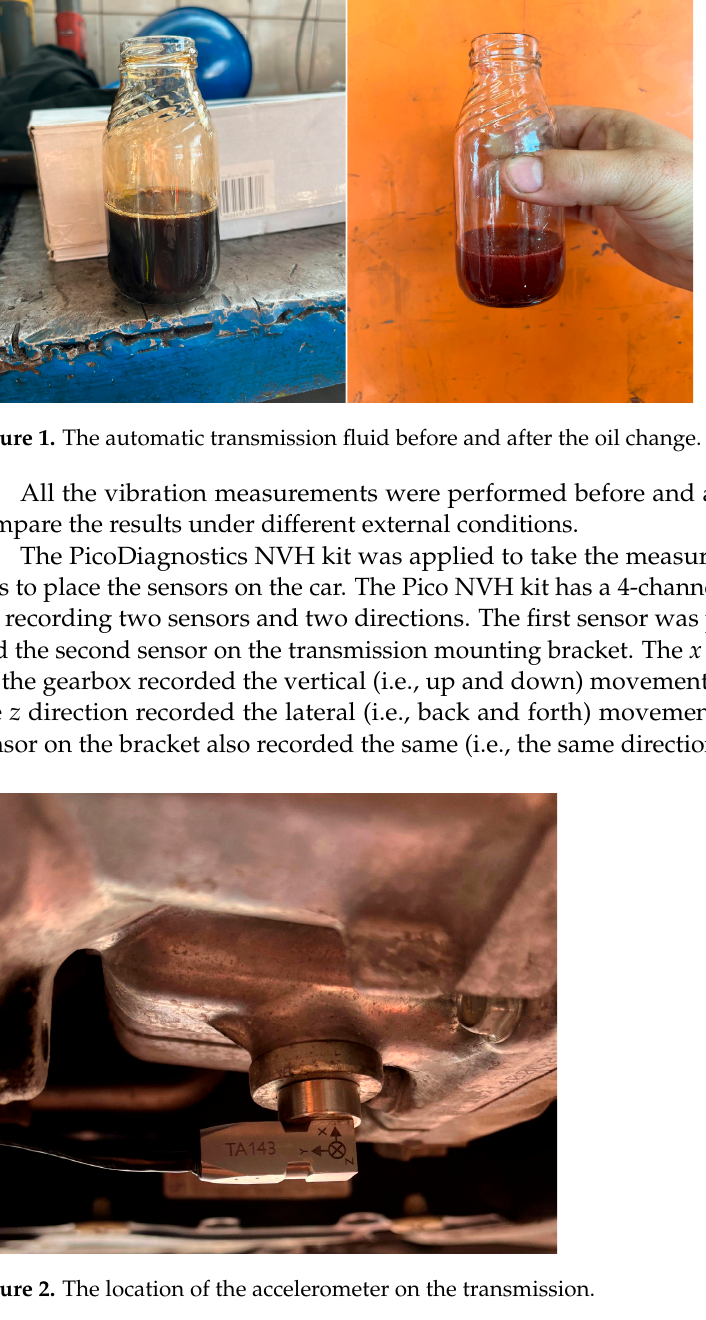
Figure 2. The location of the accelerometer on the transmission. down movements by channel D (yellow